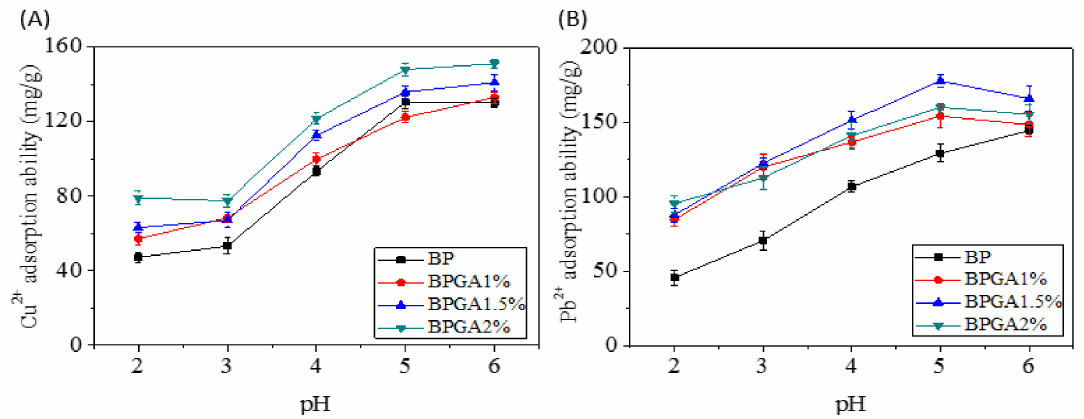
Figure 6. The e ff ect of pH on the adsorption performance for Cu 2 + ions ( A ) and Pb 2 + ions ( B